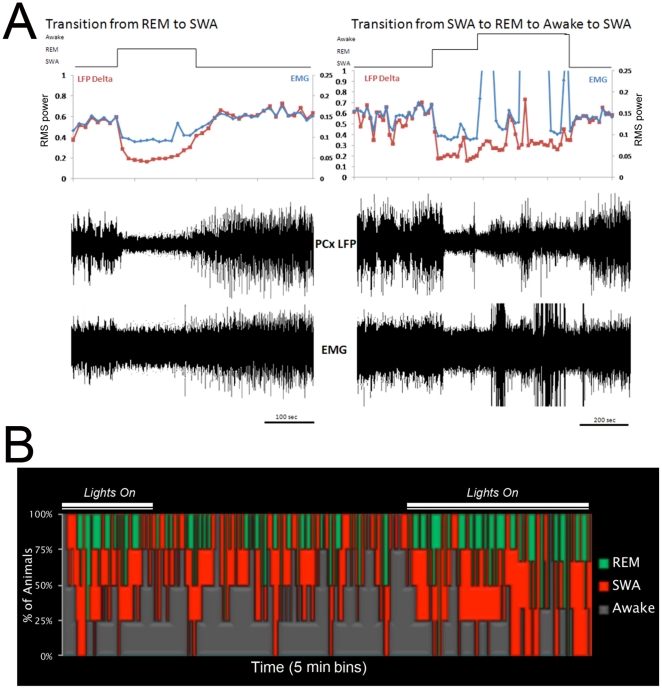
Representative data from one animal showing transition between behavioral states.(A) Left, a representative example showing a transition from SWS into REM sleep and returning to SWS as recorded in the anterior piriform cortex (PCX). Each point on the line graph represents a fourteen second time window. The waveforms below are raw LFP and EMG data showing the same window of time as the line graphs above. Note the change in both LFP and EMG frequencies when the animal enters REM sleep. Right, an example of the same animal transitioning from SWS to REM to Awake then returning to SWS. SWS is characterized by high delta power activity and relatively low EMG activity. REM is typified by low delta LFP activity and very low EMG activity. Awake state is distinguished by high frequency activity (lower delta) in the LFP and high frequency EMG waveforms. (B) A mean hypnogram recorded in the anterior piriform cortex of 4 naïve rats placed individually in the recording chamber at 3 p.m. for 24 h.